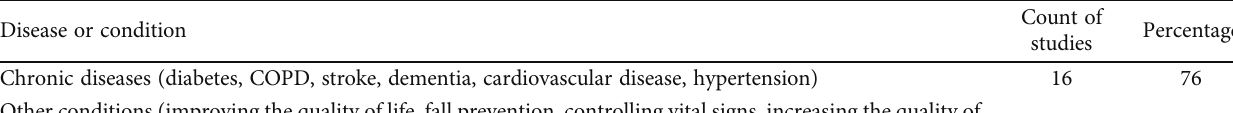
Table 2: Frequency of studies based on the disease or condition.